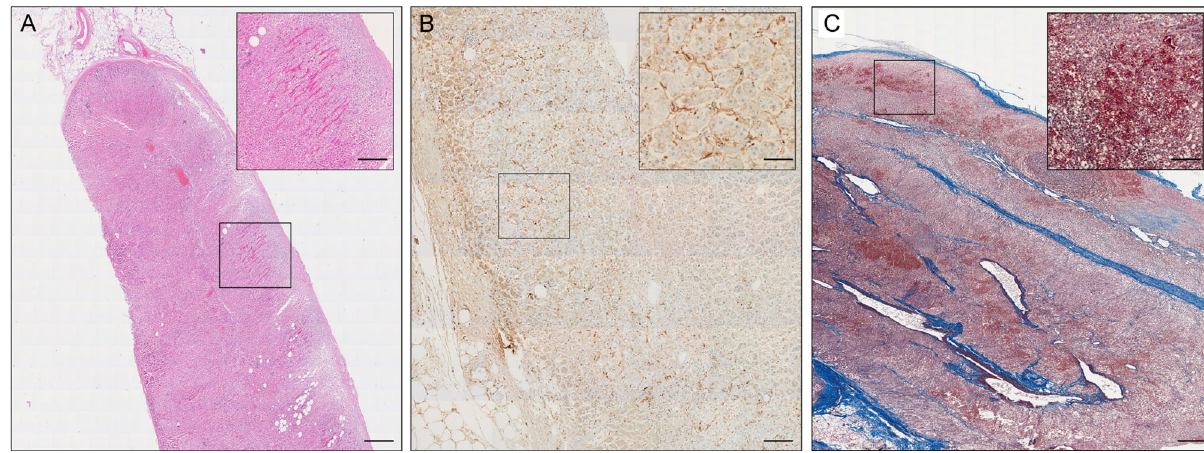
Fig. 4 Microthrombi and focal hemorrhage in adrenal glands from COVID-19 patients. Hematoxylin-eosin staining ( A ), and anti- fi brin immunohistochemistry ( B ) (overview (scale bar = 100 µ m and magni fi ed inlet (scale bar = 10 µ m) ( n = 19) shows expanded capillaries with fi brinous microthrombi. In a subset of patients focal fresh hemorrhage could be observed ( C ), Masson ’ s trichrome staining (overview (scale bar = 100 µ m and magni fi ed inlet (scale bar = 10 µ m).